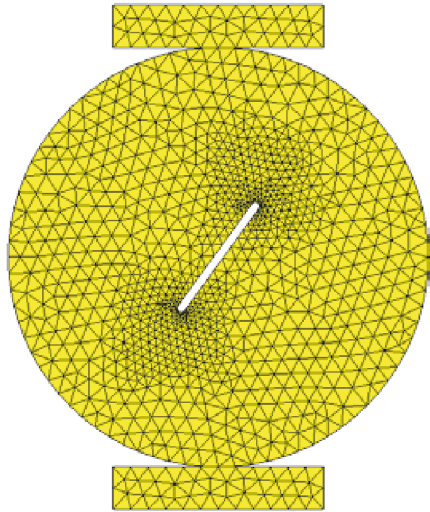
Figure 5: FEM mesh in a Brazilian disc with a preexisting crack in the center.